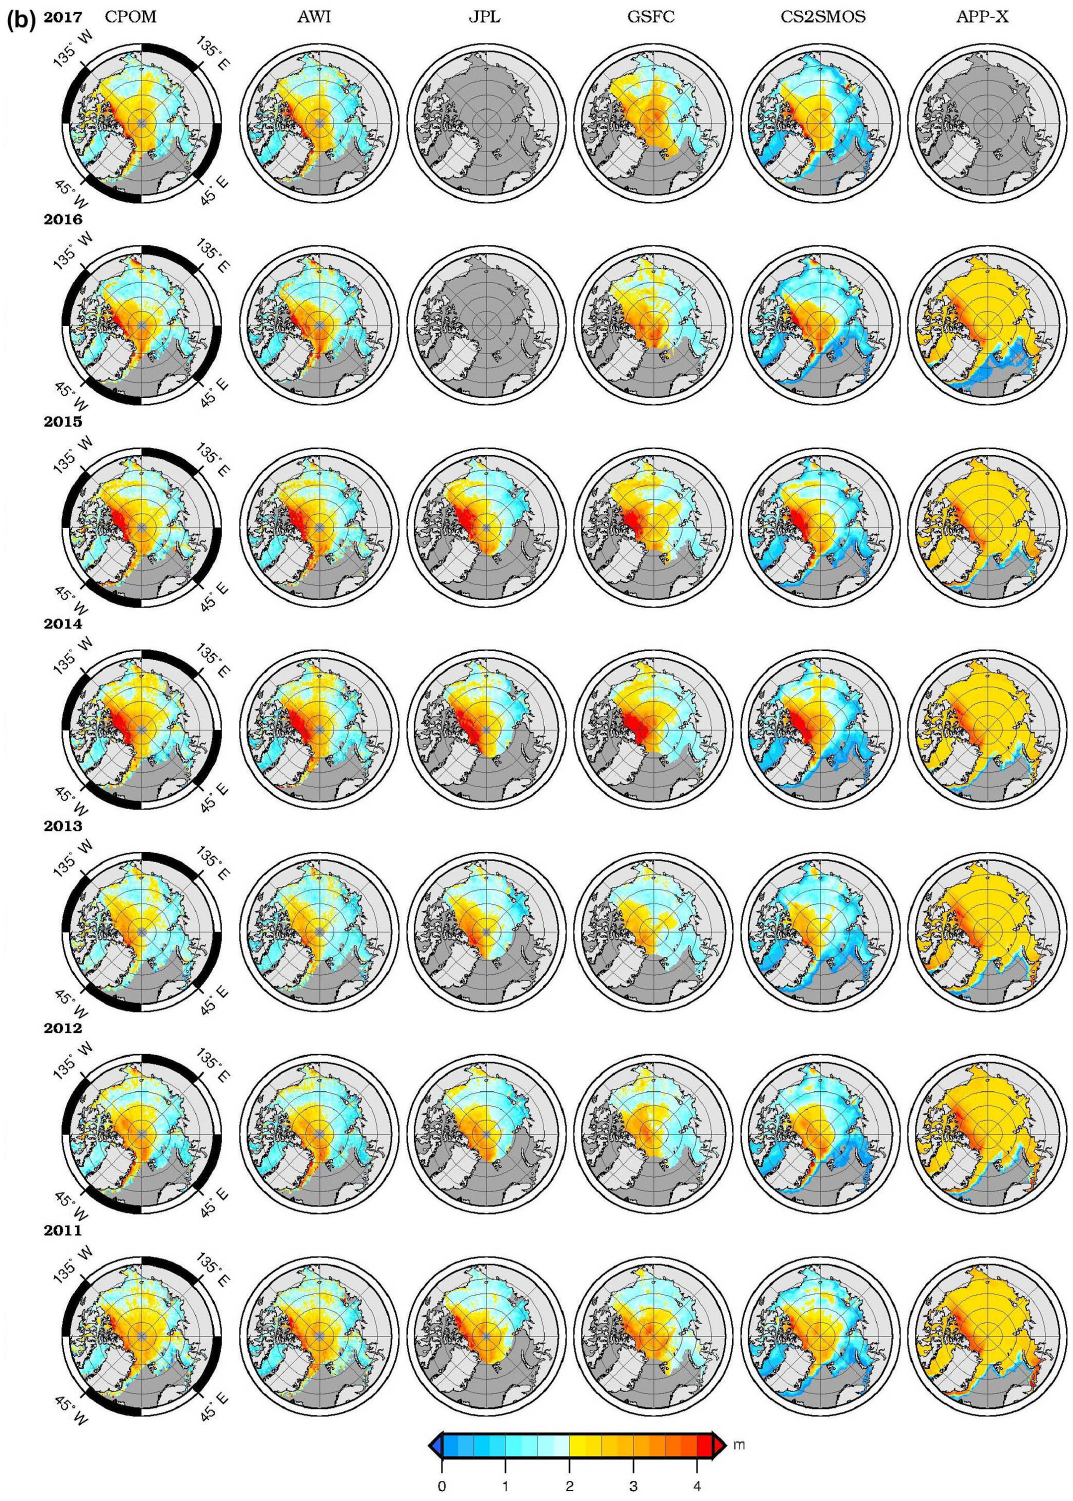
Figure 2. Maps of seasonally averaged sea ice thickness for each product over the period 2011–2017, for (a) October–November and (b) March–April, for regions 1–14, where data are available.